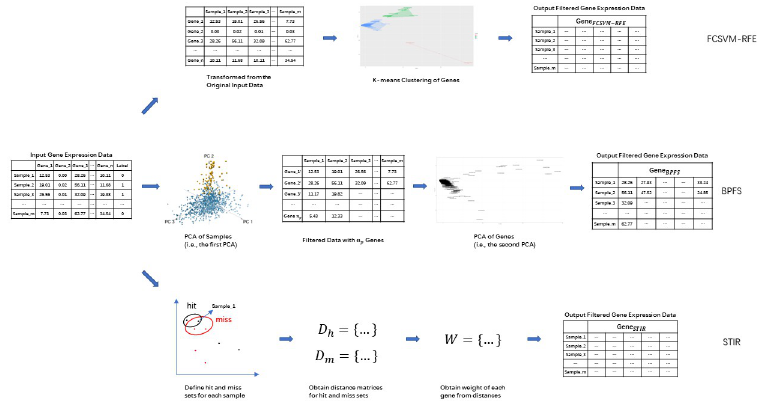
Fig 1. Different mechanisms on feature selection among FCSVM-RFE, STIR and our BPFS.